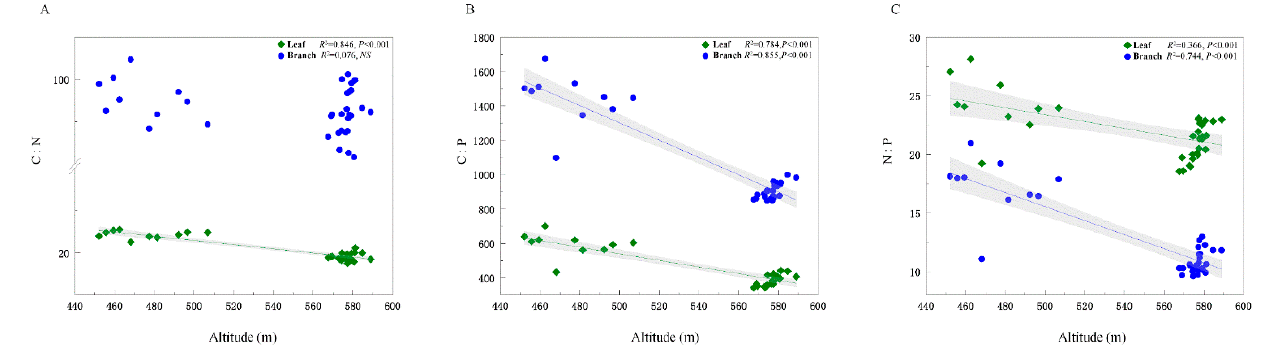
Figure 4. C, N, and P stoichiometric ratios related to altitude. C:N, ratio of carbon to nitrogen concentration ( A ); C:P, ratio of carbon to phosphorus concentration ( B ); N:P, ratio of nitrogen to phosphorus concentration ( C ). The abbreviations are shown in Figure 3.